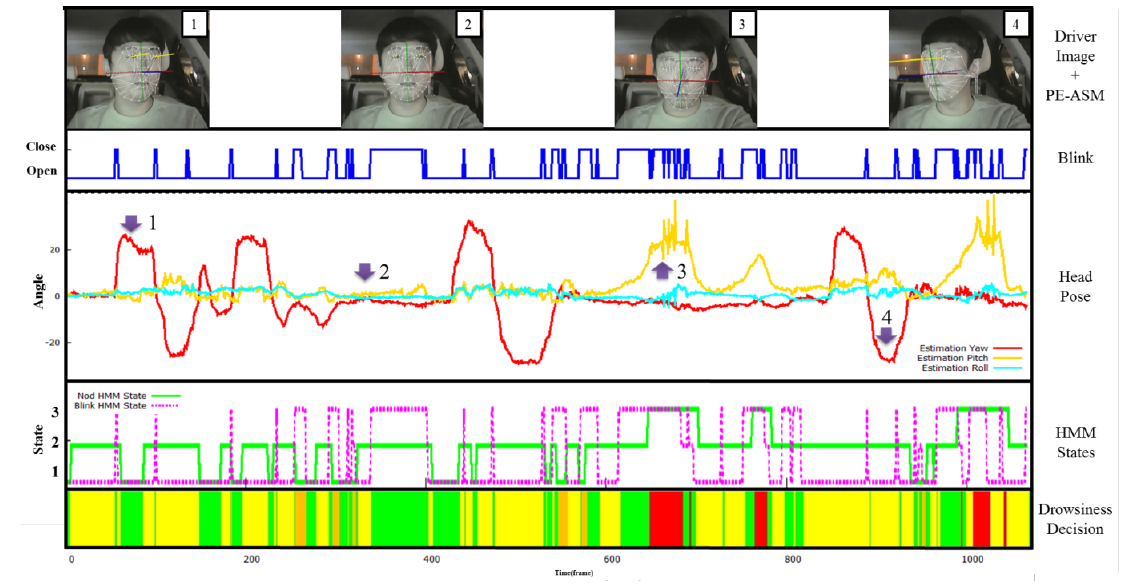
Figure 6. Note that whenever the eye-blinking and the head nodding are overlapped, the red sign, i.e. , asleep, is flashed.